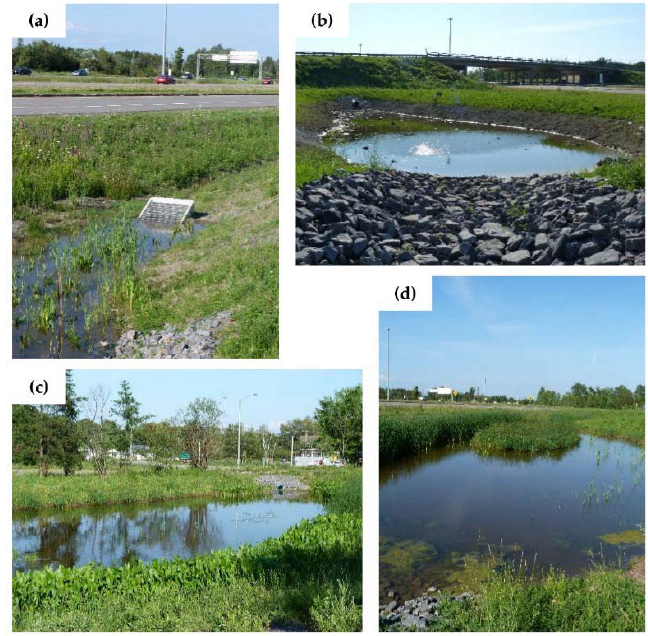
Figure 3. Pictures of the pilot site located in Saint ‐ Augustin Lake watershed (Quebec): ( a ) active filtering bed entrance sump; ( b ) detention basin; ( c ) adapted constructed wetland—deep zone; and ( d ) adapted constructed wetland—shallow zone.